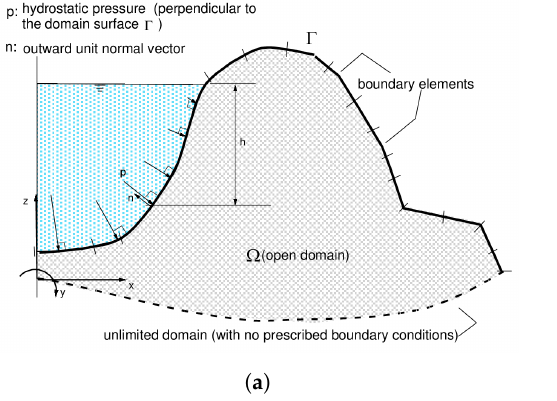
Figure 3. Water dam ( a ) BE model and ( b ) FE model